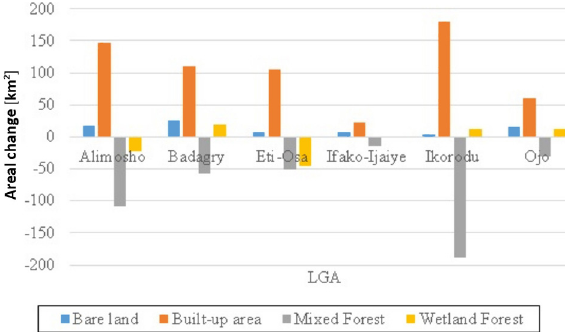
fig. 4. Areal changes in the coverage of land cover within the six focus LGAs during 1984–2019.